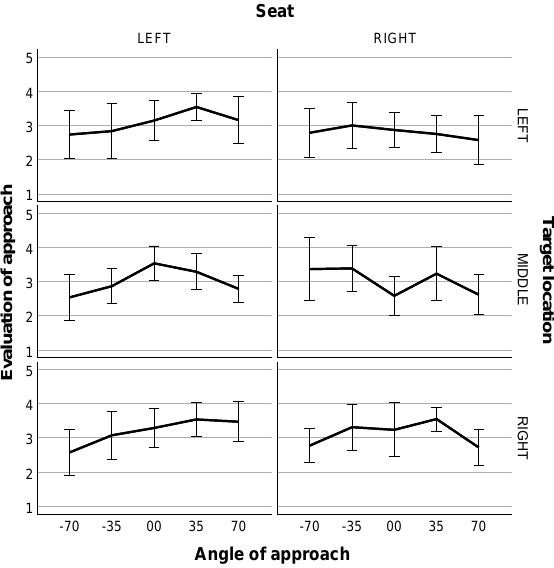
Figure 8. Average evaluation ranging from 1 (very bad) to 5 (very good) per angle of approach (ranging from − 70 ◦ to 70 ◦ ), seat, and target location in study 3: Whiskers represent 95% confidence